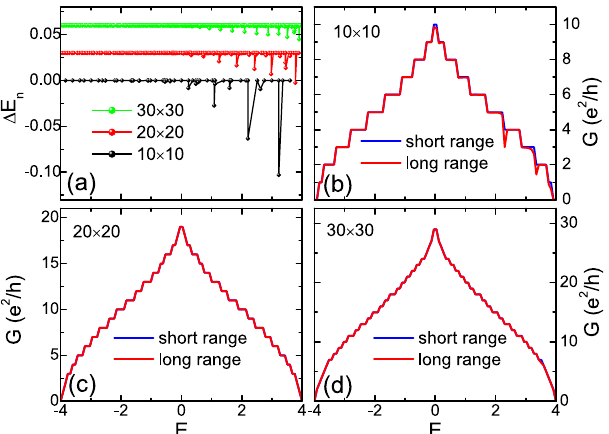
Figure 2. (Color online) Results for zero disorder and fixed boundary condition. ( a ) Difference of eigenergies (cid:31) E n ≡ E LR n − E NN n between the long range and short range models, for a finite sample with sizes 10 × 10 (black), 20 × 20 (red) and 30 × 30 (green) respectively. The latter two curves are shifted vertically for visual clarity. ( b )–( d ): the two-terminal conductance G as a function of Fermi energy E , for a short range (blue curve) and long range model (red curve), with sample size 10 × 10 ( b ), 20 × 20 ( c ) and 30 × 30 ( d ). Most of the blue curves have been covered by red curves due to an almost perfect match. The transport setup is shown in Fig. 1a,b.